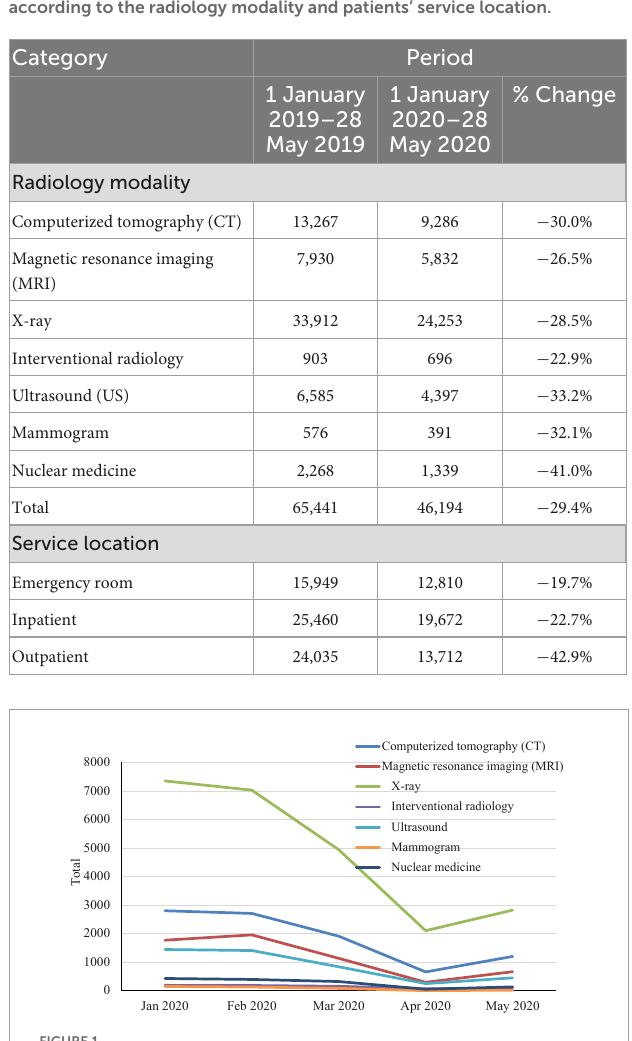
FIGURE1 The change in imaging case volumes over time in January–May 2020 stratified by imaging modality.